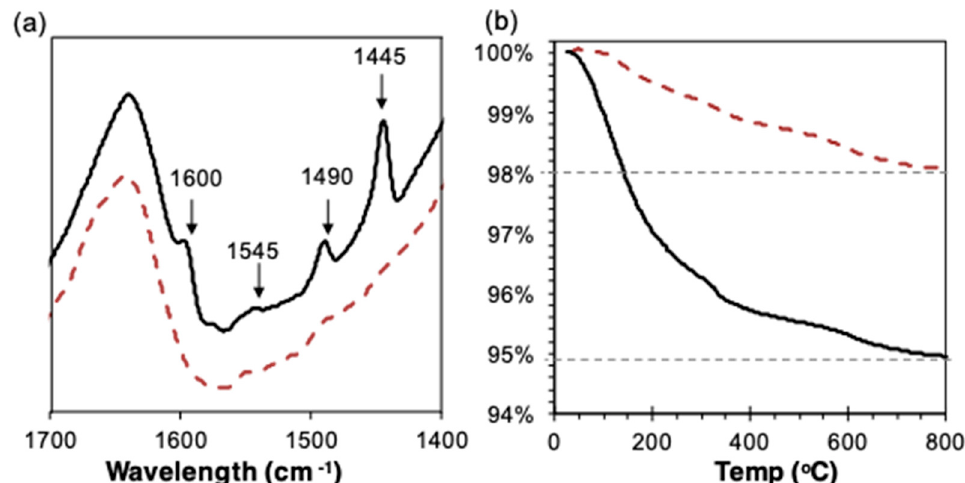
Figure 4. Acidity characterisation of Huntly-GP catalyst. ( a ) FTIR spectra of pyridine chemisorption; ( b ) thermogravimetric analysis (TGA) profile of the desorbed pyridine. The broken lines represent the background sample without pyridine.